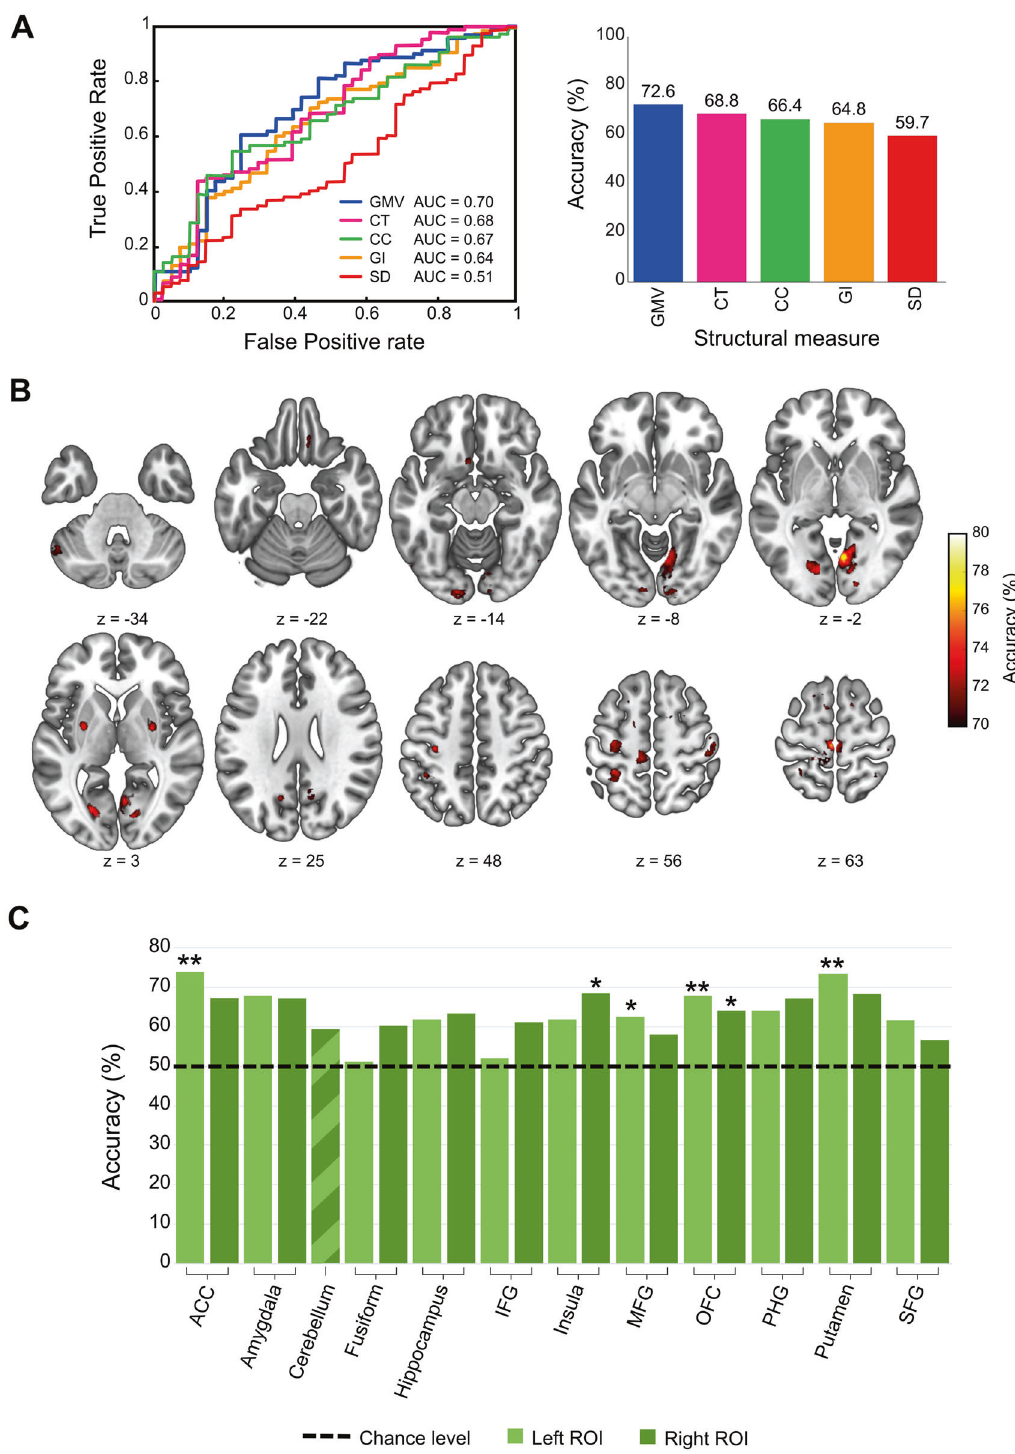
Fig. 3 Classi fi cation results. A Pattern classi fi cation of women with premenstrual dysphoric disorder and healthy controls based on the fi ve structural measures over the whole-brain. Receiver operating characteristic (ROC) curves and corresponding area under curve (AUC) are displayed for each structural measure in the left graph. Mean accuracies of classi fi cation are presented in the right graph. B Classi fi cation accuracy map of the searchlight MVPA (voxel-wise) based on the GMV images. The centres of searchlight spheres where higher-than-chance level accuracies were found under the threshold p < 0.001 (uncorrected) are depicted in red-yellow on axial brain slices. The classi fi cation accuracy under this threshold ranged from 58.0 to 78.6% across the brain. For visualization purposes, only the accuracies >70% are displayed. C ROI-based classi fi cation based on GMV images results. The chance-level threshold (50% accuracy, 0.5 AUC) is indicated by the horizontal black dotted line. * p < 0.05, uncorrected for multiple testing ** p < 0.05 Bonferroni-corrected ( p Bonferroni < 0.0022). GMV grey matter volume, CT cortical thickness, CC cortical complexity, GI gyri fi cation index, SD sulcal depth, ACC anterior cingulate cortex, Fusiform fusiform gyrus, IFG inferior frontal gyrus, MFG middle frontal gyrus, SFG superior frontal gyrus, OFC orbitofrontal cortex, PHG parahippocampal